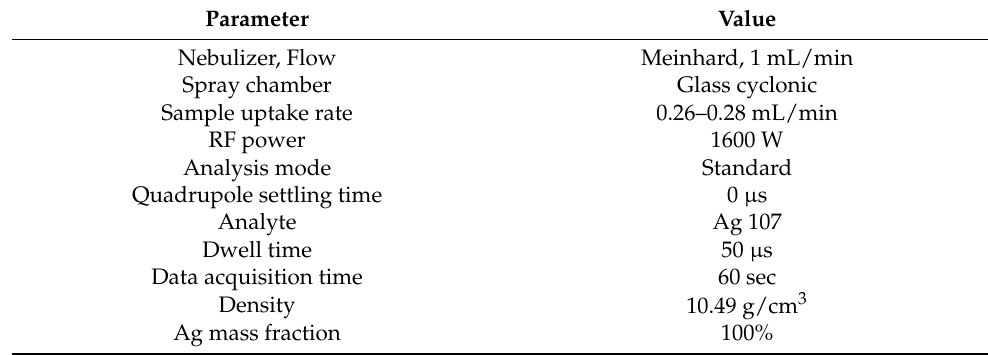
Table 1. NexION ® 350D ICP-MS instrumental condition for single particles